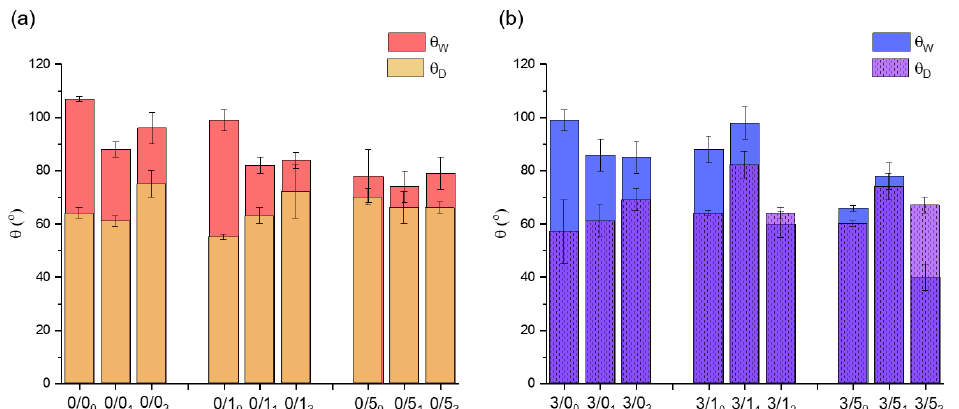
Figure 2. Contact angles of water ( θ W ) and diiodomethane ( θ D ) on films made of PLA, Mg particles and CTAB for non-degraded and degraded samples for 1 and 3 months. ( a ) Non-containing mag- nesium films; ( b ) magnesium-containing films. The texture of θ D is included to differentiate more clearly between cases in which θ D > θ W . All data are given as mean and standard deviation.